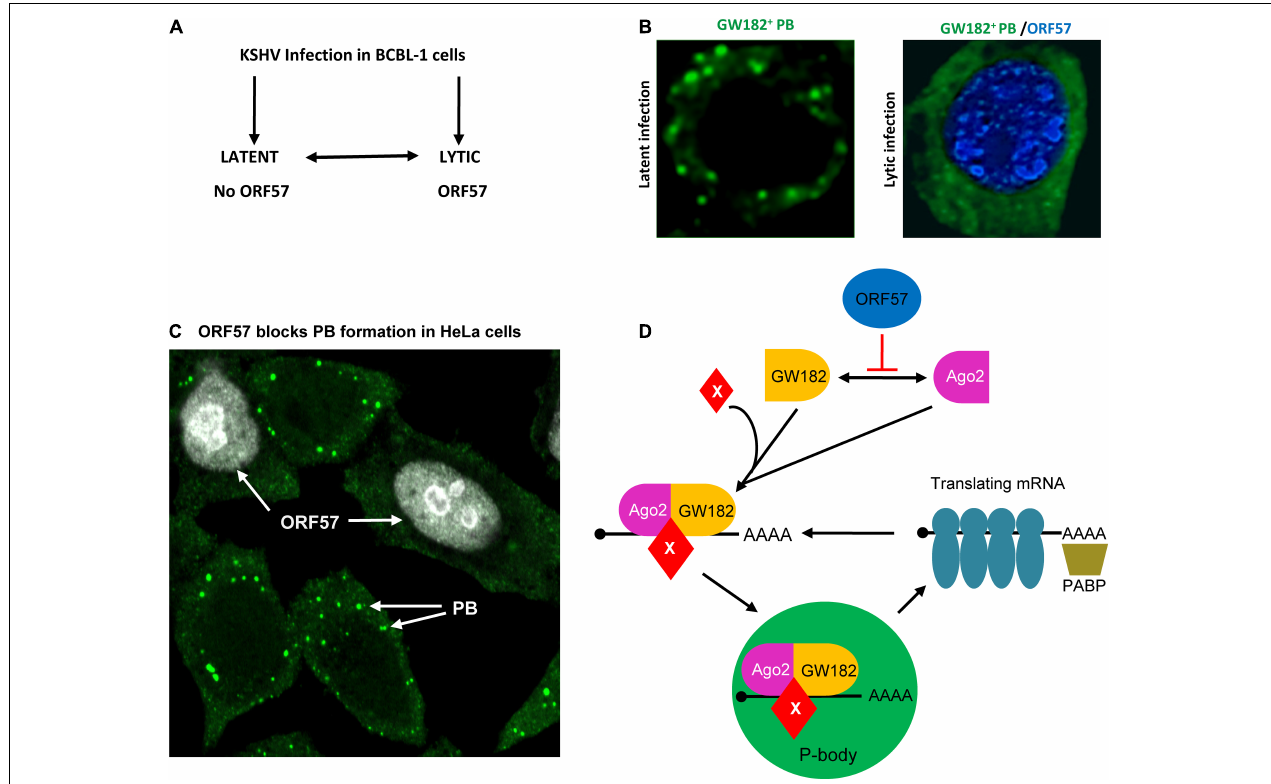
FIGURE 2 | Inhibition of PB assembly during Kaposi’s sarcoma-associated herpesvirus (KSHV) lytic infection. (A) Flow diagram showing the exchangeable progression of lytic and latent phases of KSHV infection in BCBL-1 (B lymphocytes) cells. KSHV ORF57 is expressed only in viral lytic infection. (B) Left panel, a BCBL-1 cell carrying latent KSHV infection showing PB (green), after immunostaining with an anti-GW182antibody. Right panel, inhibition of PB assembly during KSHV lytic infection by expression of viral ORF57 (blue). (C) Inhibition of PB formation by ectopic ORF57 in HeLa cells. (D) Schematic model depicting the steps of KSHV ORF57 inhibition of PB formation during KSHV lytic infection by direct interaction with Ago2 and GW182. The mRNA translation can be stopped by RNA-induced silencing complex (RISC) including Ago2-GW182 complex with other factors shown as X. As a result, the translating mRNA can be stripped of ribosomes and the translational complex can be collapsed when binding to the Ago2-GW182-X complex. Panel (D) is modified from our previously published figure (Sharma et al., 2019).